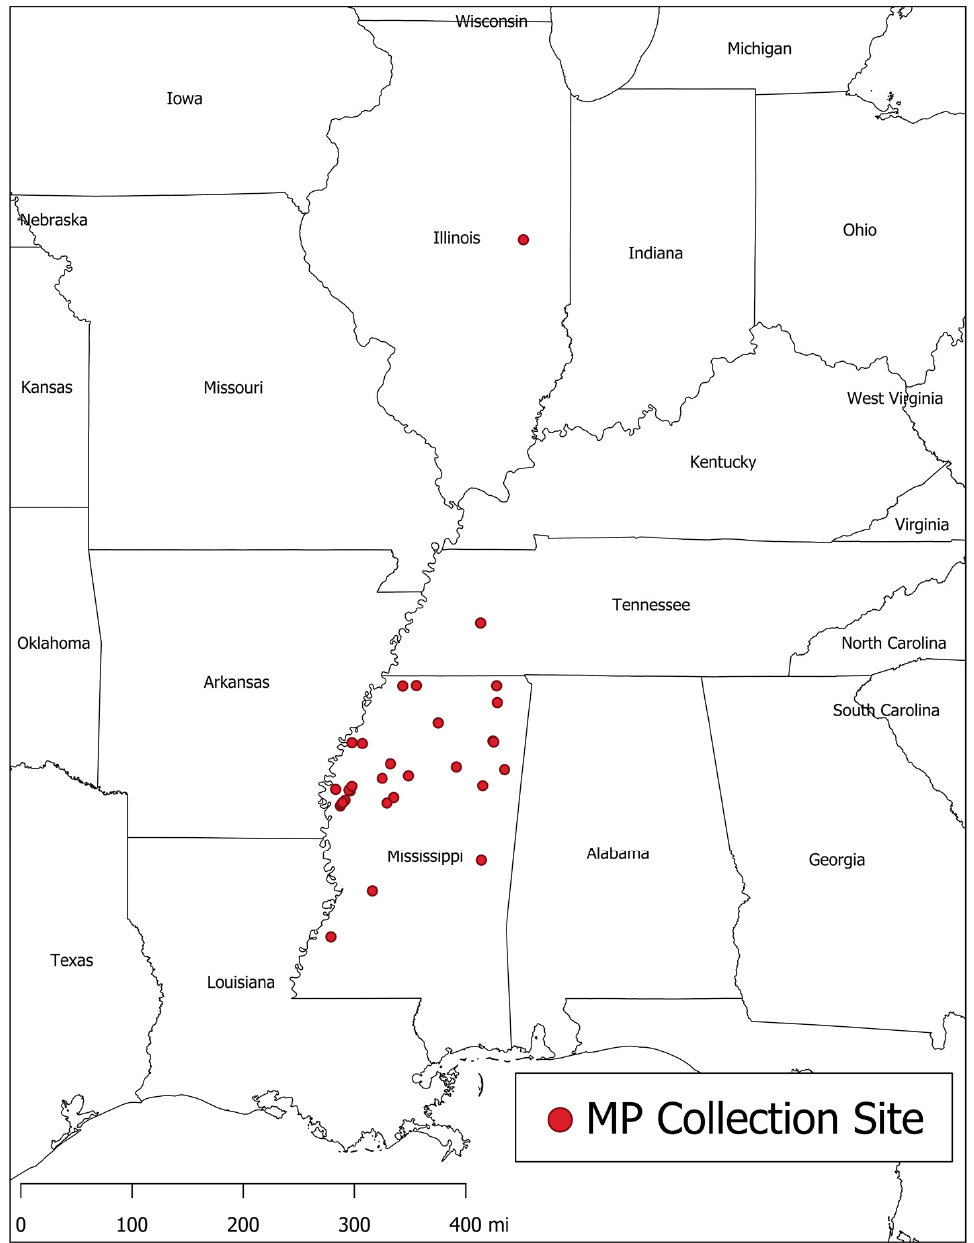
Figure 2. Map of M. phaseolina collection sites in the United States. Each point represents a site where one or more isolates of M. phaseolina were collected. There were 31 collection sites in total. The map was generated using QGIS software [24] and cartographic boundary files were provided by the US Census Bureau [25].